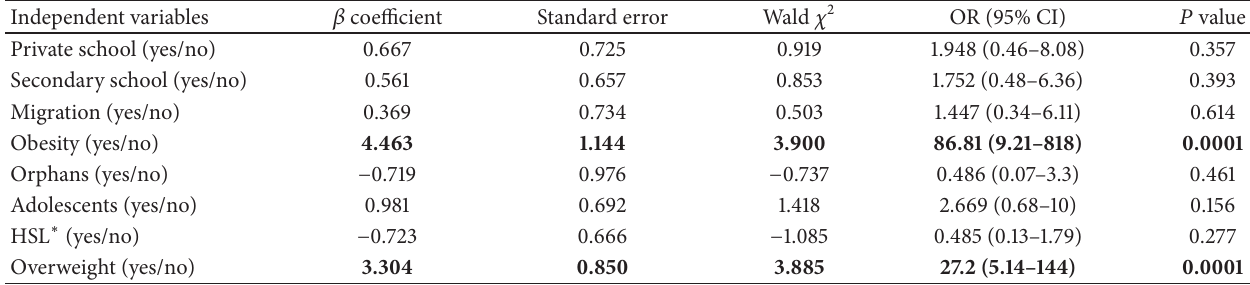
Table 6: Logistic regression to determine the independent role of type of school, obesity, orphans, adolescence, HSL, and overweight on presence of HT in